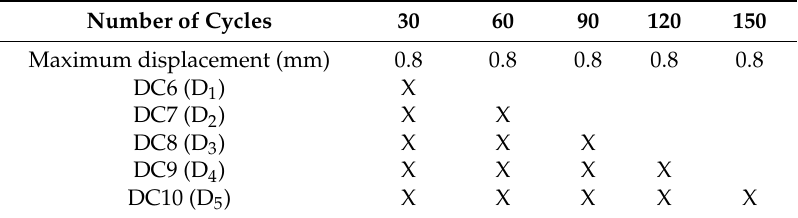
Table 2 Number of cycles and maximum displacement reached by specimens DC6 to DC10. Table 2. Number of cycles and maximum displacement reached by specimens DC6 to Number of Cycles